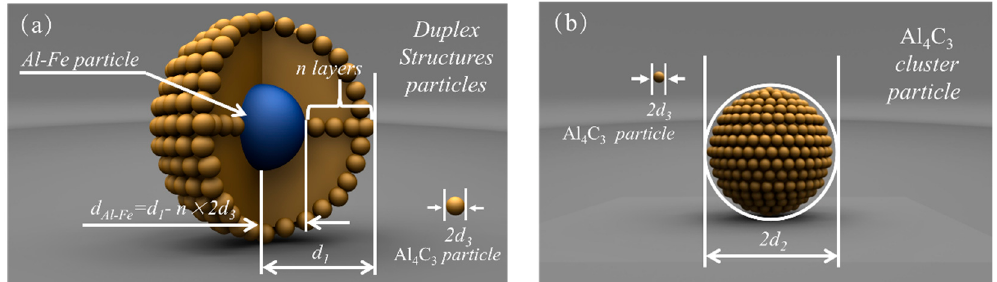
Figure 8. Calculation model of the duplex and single structure particle.